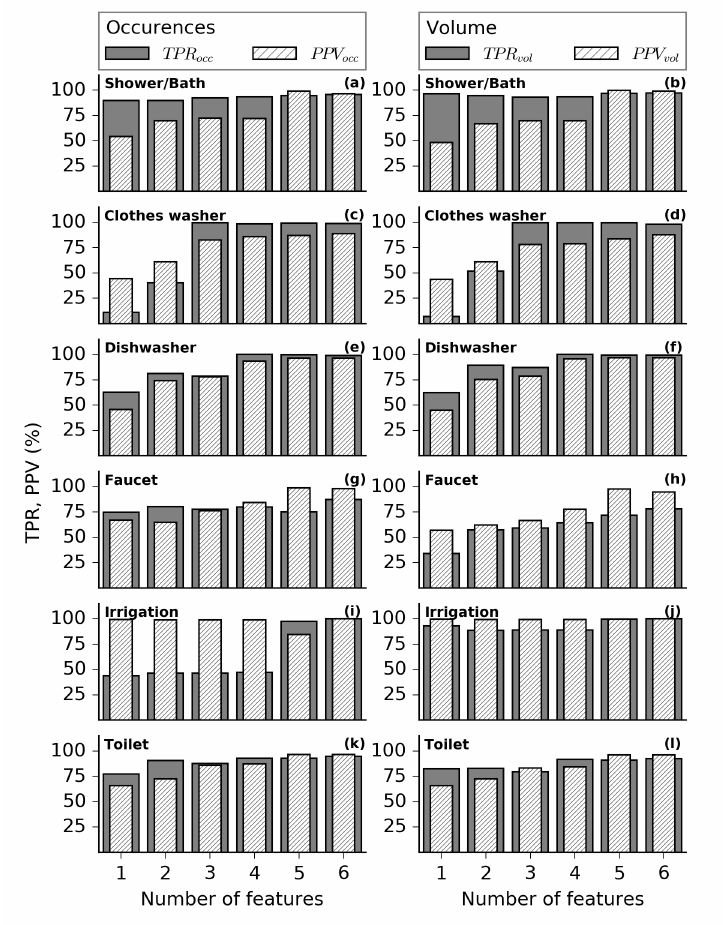
Figure 5. Classifier accuracy generally improves when adding input features, although accuracy gains from one category can come at the expense of another category. For example, adding event duration as the second feature improves ( h ) TPR faucet while slightly reducing ( b ) TPR shower . vol vol The six-feature classifier achieves TPR occ ≥ 95% for all categories except faucets, which is